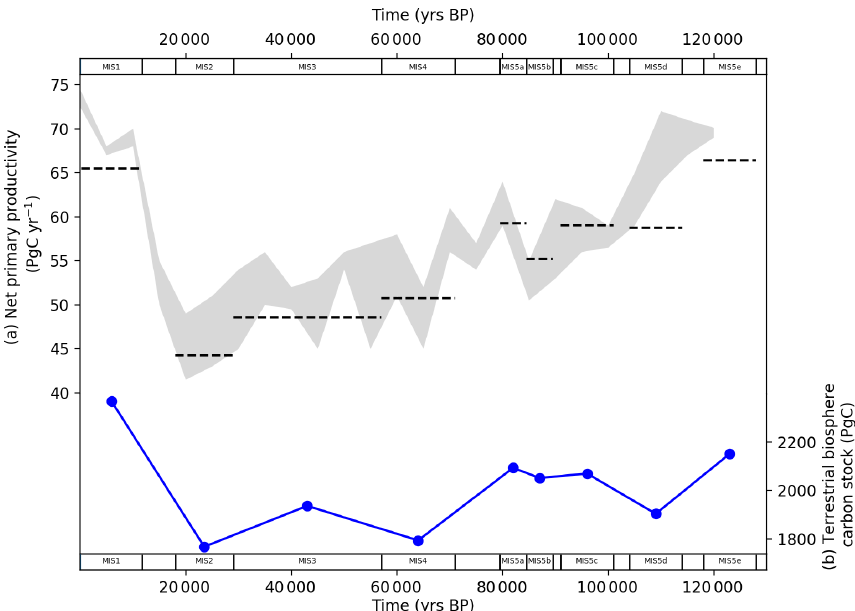
Figure 12. (a) Model–data output for the terrestrial biosphere net primary productivity (NPP) in each MIS time slice (black dashed lines) compared with the range of estimates provided by Hoogakker et al. (2016) (grey area). (b) Model–data output for the terrestrial biosphere carbon stock for each MIS time